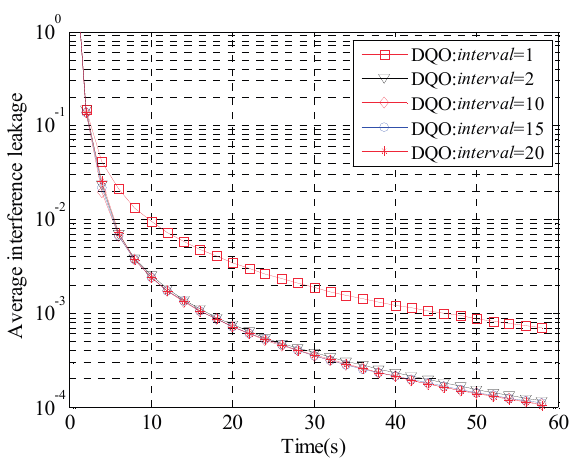
Figure 5. Convergence curves of the average interference leakage of DQO algorithm with interval = 1, 2, 10, 15, and 20 in (10 × 10, 1) 19 .